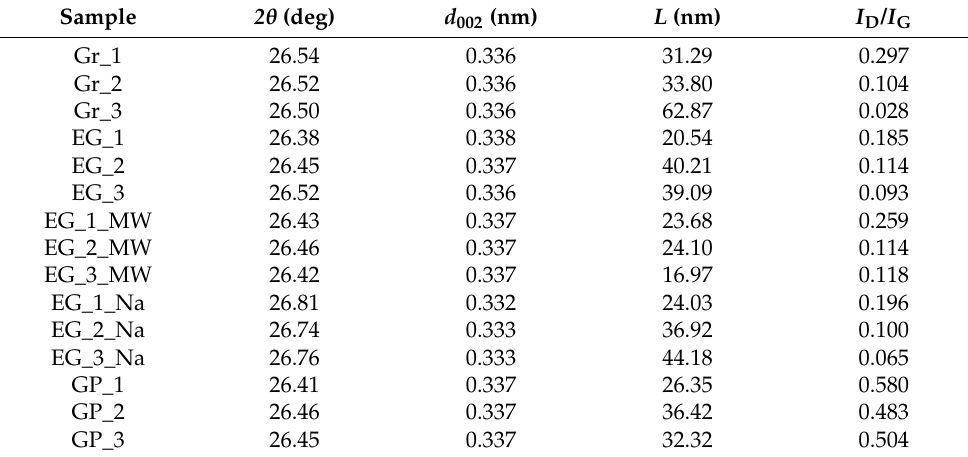
Table 1. Data obtained from XRD analysis (positions, interplanar spacing d 002 , and crystallite size), and Raman spectra ( I D / I G